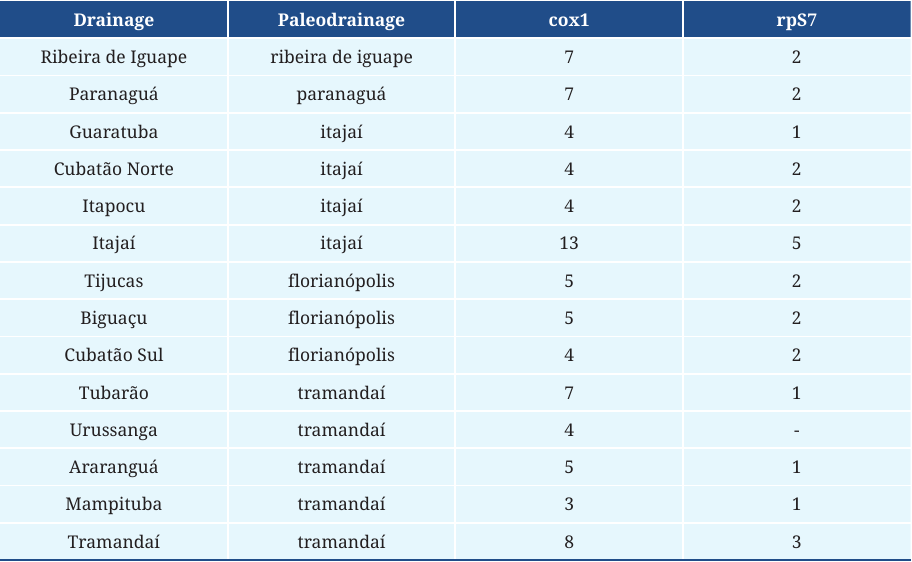
TABLE 1 | Number of samples sequenced for Cytochrome Oxidase subunit 1 (cox1) and rpS7 ribosomal protein gene intron 1(rpS7) genes by drainage (populations) and its respective